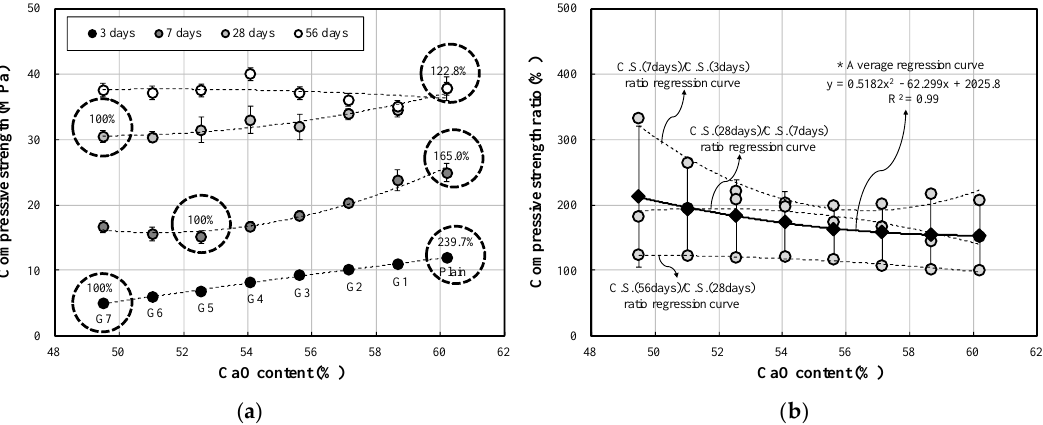
Figure 10. Results of ( a ) compressive strength and ( b ) compressive strength ratio with respect to CaO